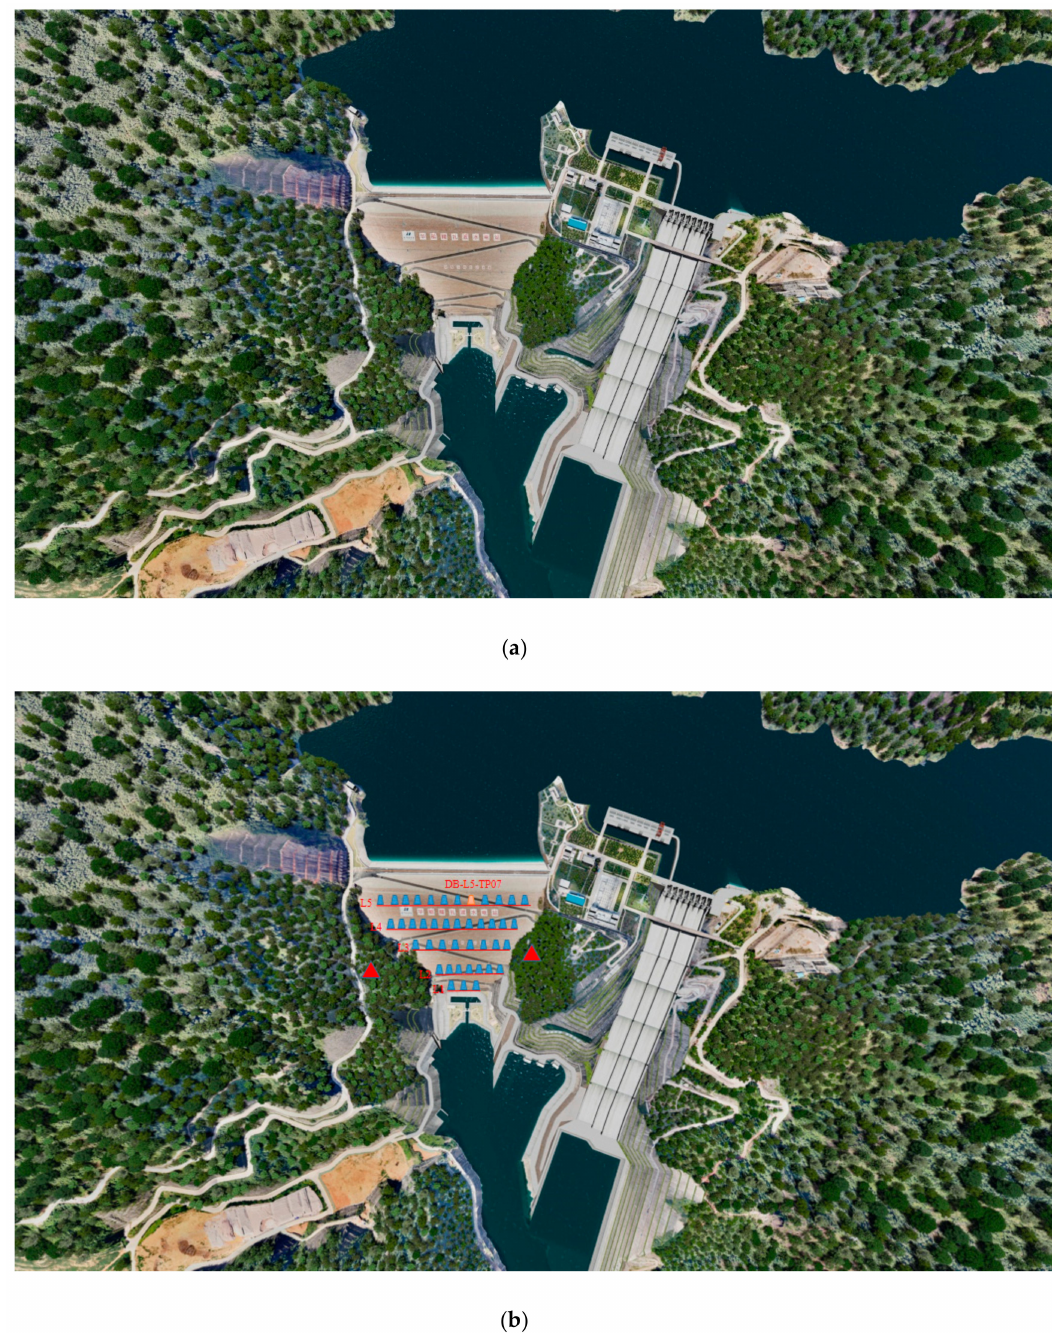
Figure 1. ( a ) Schematic diagram of Nuozhadu dam (Top view). ( b ) Collimation lines and typical measuring points. Five collimation lines (L1–L5) were established on the surface of the downstream dam slope to monitor the surface deformation of the rock-fill body, and the typical measurement point DB-L5-TP-07 was selected as an